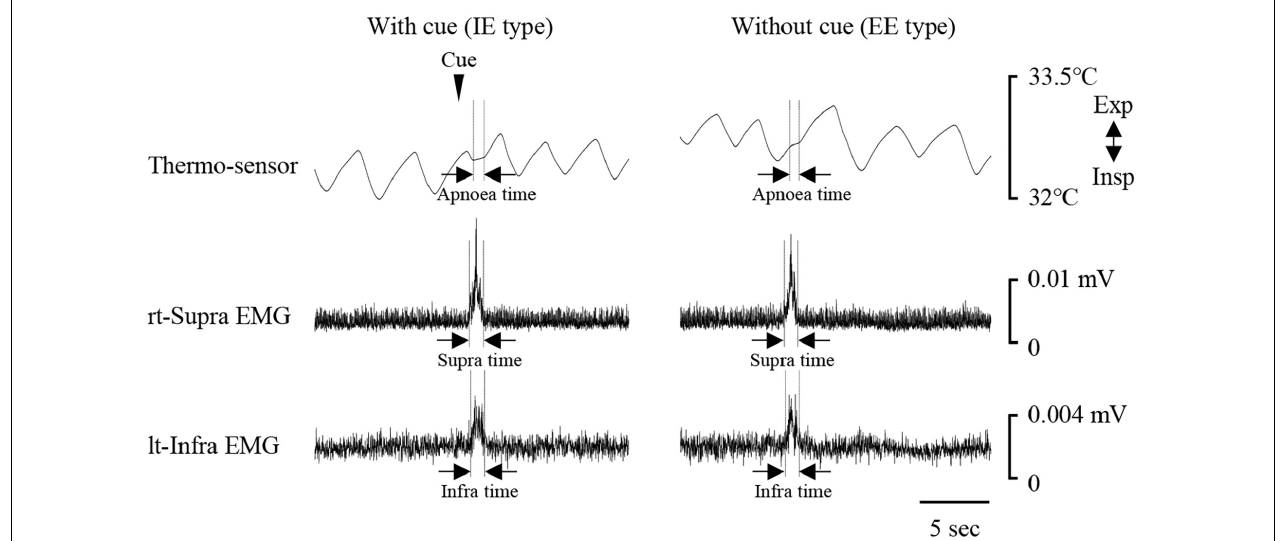
FIGURE 1 | Examples of respiratory and swallowing recordings during 3-ml water swallowing with (left) and without cue (right). Electromyography (EMG) waveforms were rectified and smoothed. Periods of swallowing apnoea and EMG burst are shown by dotted lines. The coordination pattern was inspiration–swallow–expiration (IE) with cue (left), and expiration–swallow–expiration (EE) without cue. The timing of cueing is indicated by an arrowhead. lt-Infra, left infrahyoid, rt-Supra, right suprahyoid.